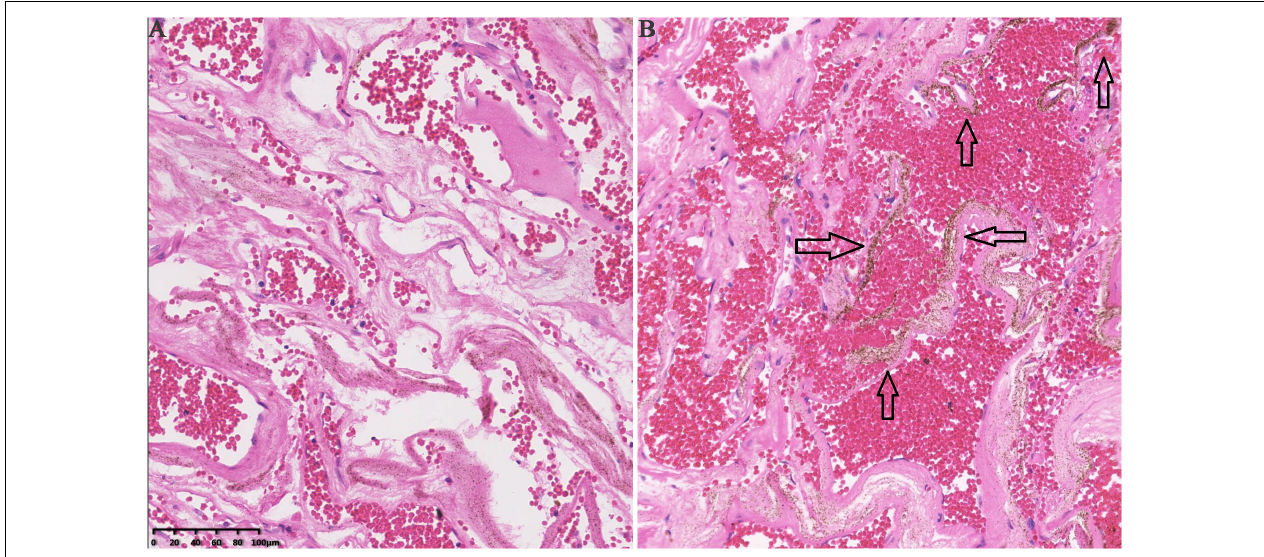
FIGURE 2 | Pathological histology of CCMs specimen from the proband patient. (A) H&E staining demonstrated the back to back arrangement of the dilated vessels and the thin-walled capillaries that lacked of tunica media. (B) The hemosiderin pigments (blank arrows) were detected in surrounding tissues.